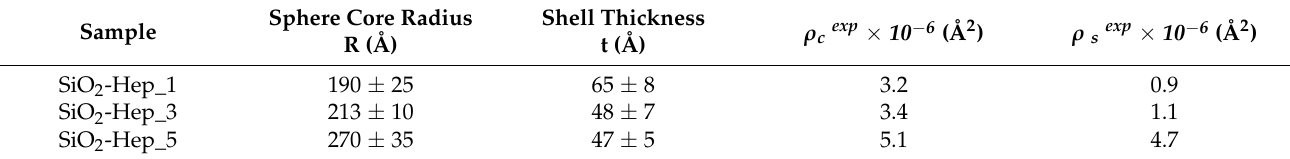
Table 3. Properties of hybrid SiO 2 /Hep nanostructures obtained by the best fitting of SANS curves. Sphere Core Sample